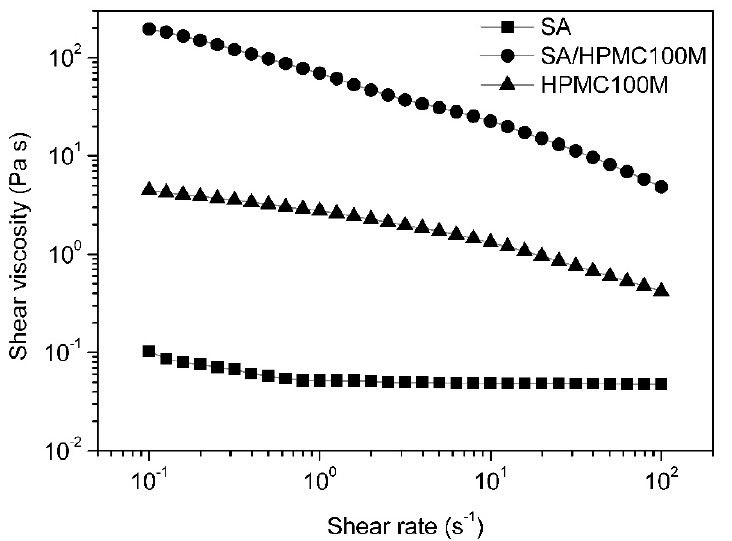
Figure 2. Viscosity curves of 2% dispersions of retarding excipients in PBS pH 6.8. SA—sodium alginate; HPMC100Mhypromellose Methocel K100M; SA/HPMC100M—mixture of sodium alginate and hypromellose in a ratio of 1:1. Table 6. Values of power law index n ( − ) of the dispersions of tableting materials in PBS pH 6.8. Retarding Component n Values for CH n Values for CH/P90 SA 30% 0.5847 ± 0.005 0.5356 ± 0.047